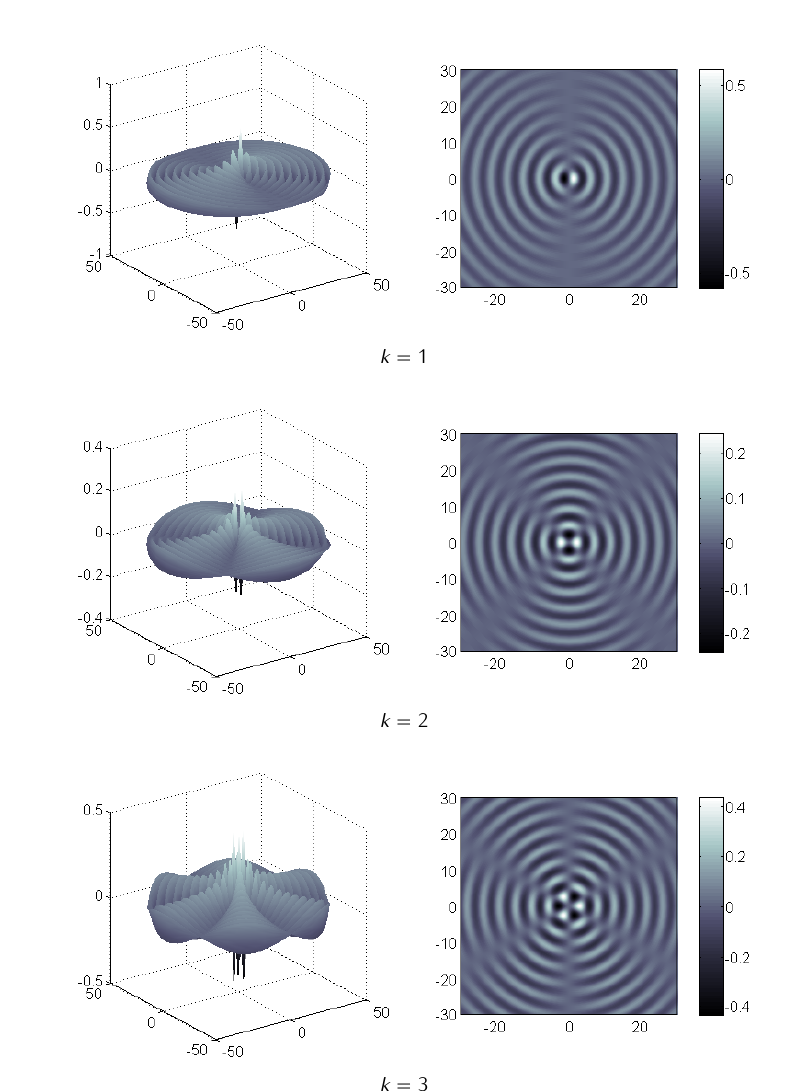
√ σξ ) cos( kφ ) to the linearized equation (36), k = 1 , 2 , 3 ( ξ,φ ) = J k (